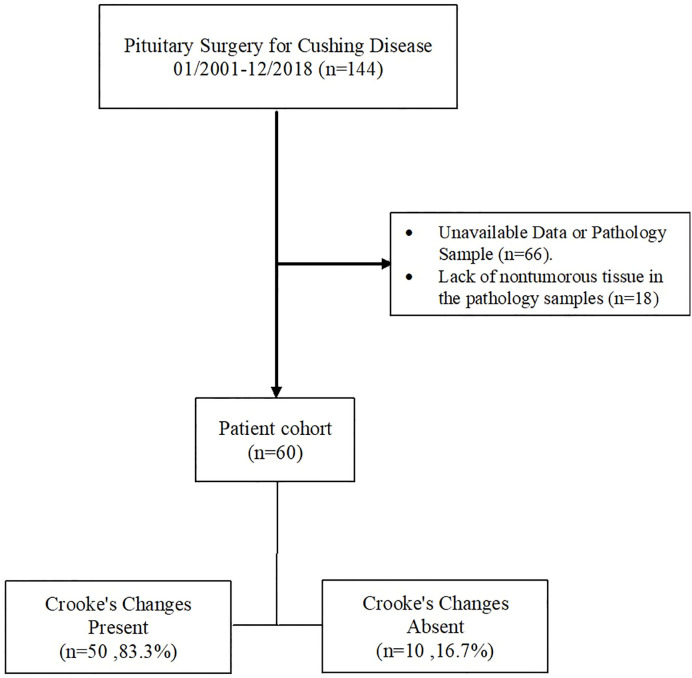
Flow diagram of exclusion criteria to arrive at the final analysis profile. The records of all patients who had pituitary surgery between January 2001 and December 2018 were screened as described in the text.